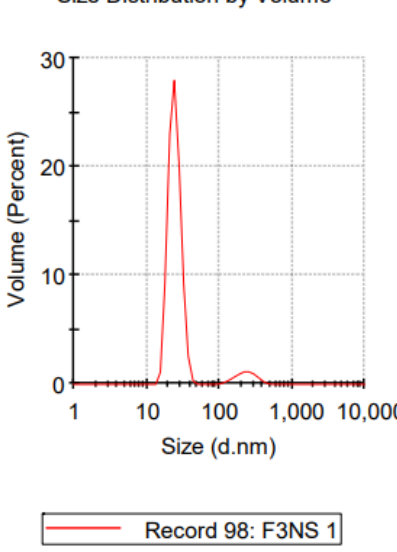
Figure 3. Representative of DLS graph of NS-3.